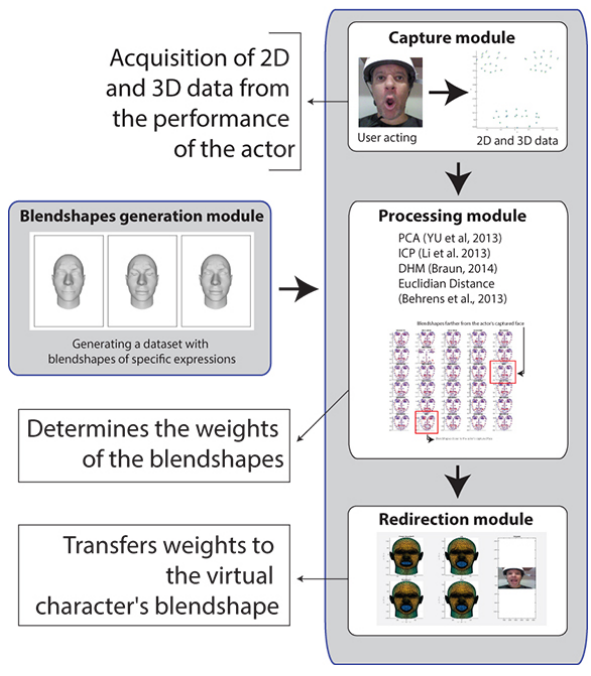
Fig. 2. Architecture and pipeline of the developed